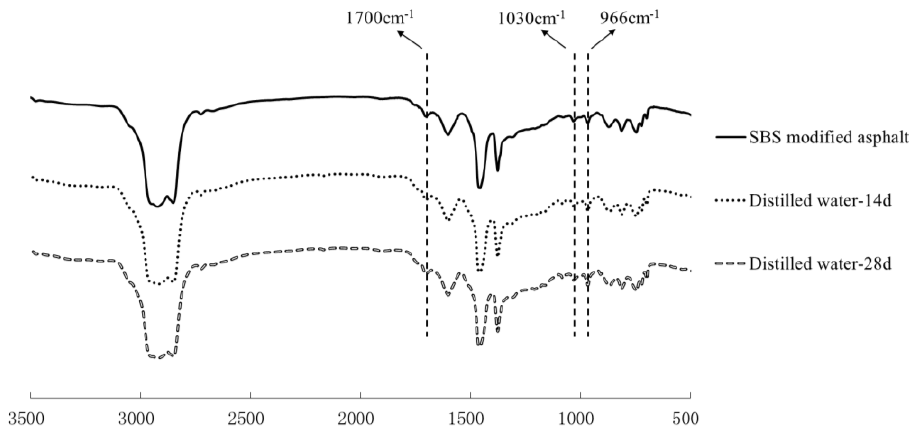
Figure 7. FTIR spectra of the SBS modified asphalt before and after distilled water aging.